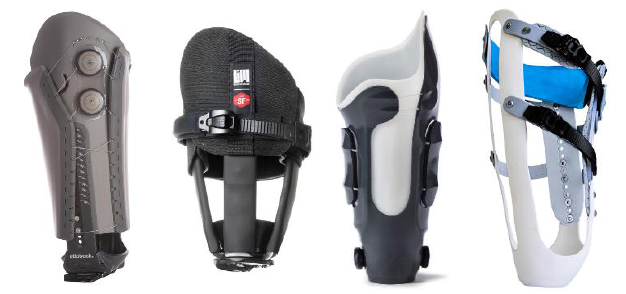
Figure 1: Examples of prefabricated, modular, custom with adjustable element, and custom-hybrid adjustable-volume sockets. Left to Right: Ottobock Varos, LIM Innovations Infinite TF, Click Medical RevoFit, Martin Bionics Socket-less